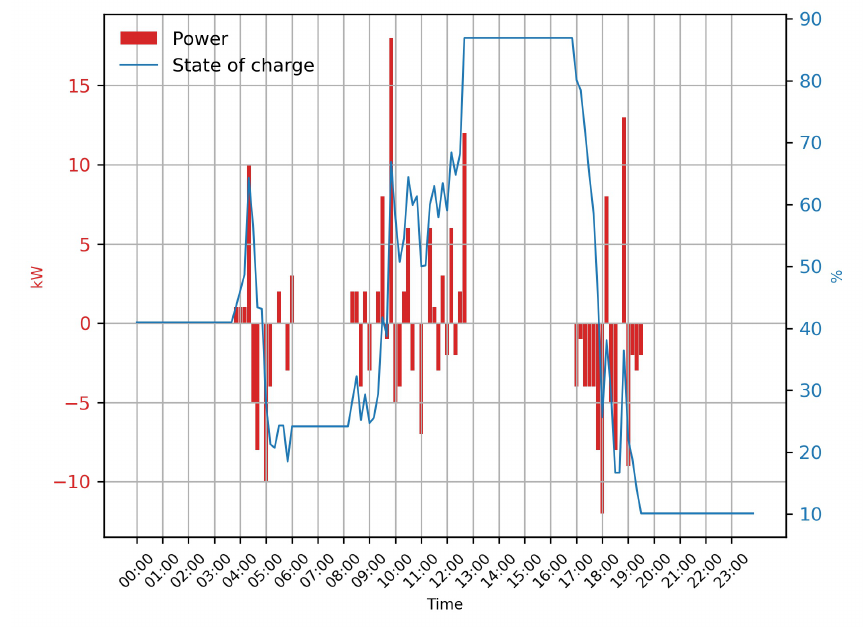
Figure 14. Energy storage system power profile for the profile in Figure